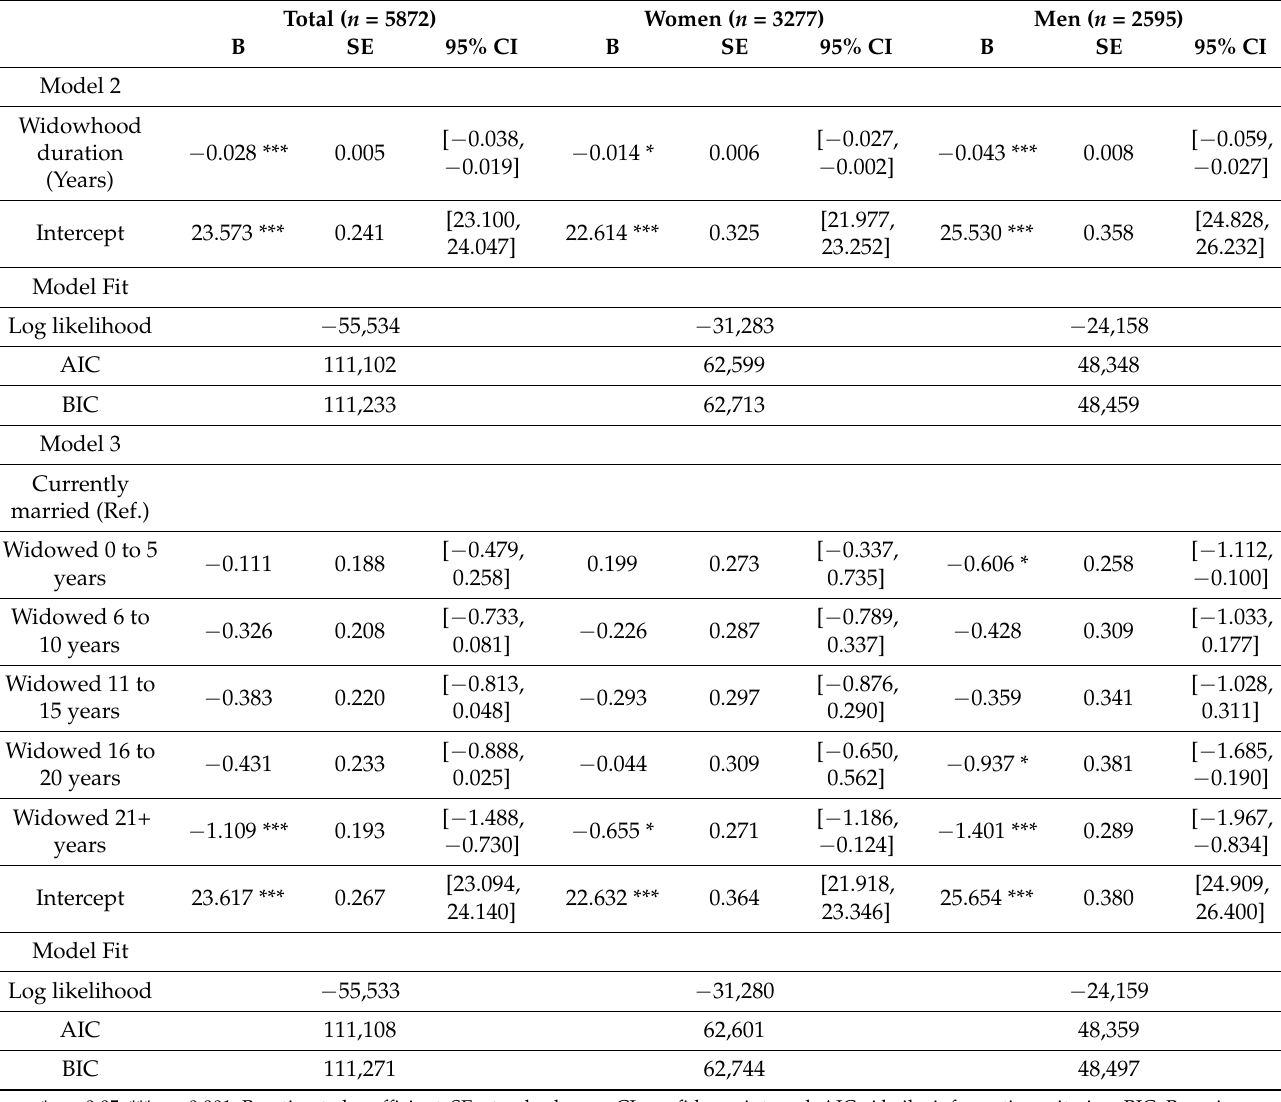
Table 4. The association between widowhood duration and cognitive